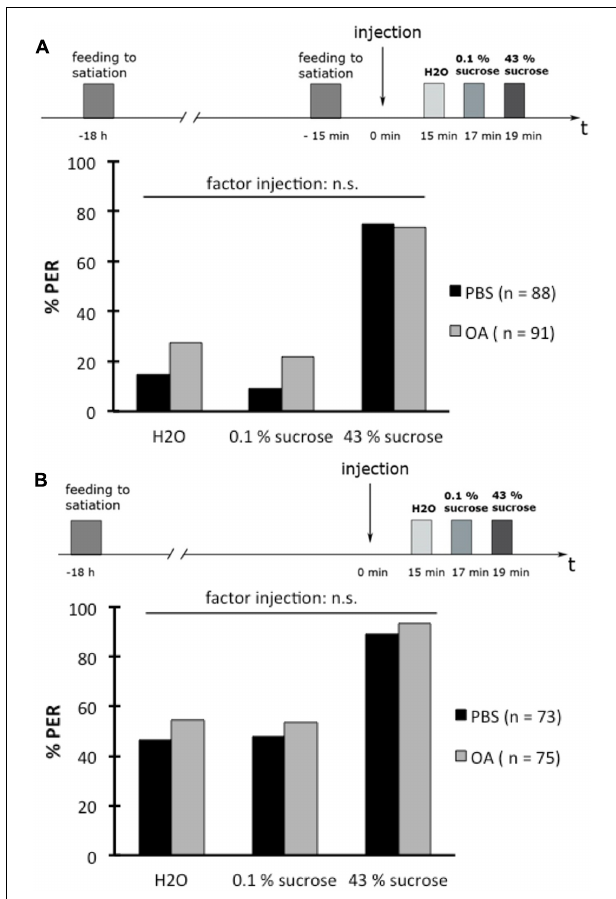
FIGURE 8 | Epinastine blocks the proboscis extension response (PER) of hungry honeybees. (A) Schematic overview of the experiment (above). Bees were fed to satiation with 30% (w/v) sucrose solution (0.88 M)18 h and again 15 min before drug injection. The PER was tested 15 min after drug injection with water (H 2 O), with 0.1% (w/v) sucrose solution (2.9 mM) (0.1% sucrose), and with 43% (w/v) sucrose solution (1.25 M) (43% sucrose). Epinastine (EPI) did not affect the PER to these different solutions in sated bees (below). (B) Schematic overview of the experiment (above). Bees were fed to satiation with 30% (w/v) sucrose solution (0.88 M) 18 h before drug injection. The PER was tested 15 min after drug injection as described in (A) . EPI blocked the PER of hungry bees (below). ∗ p < 0.05. Number of bees appears in